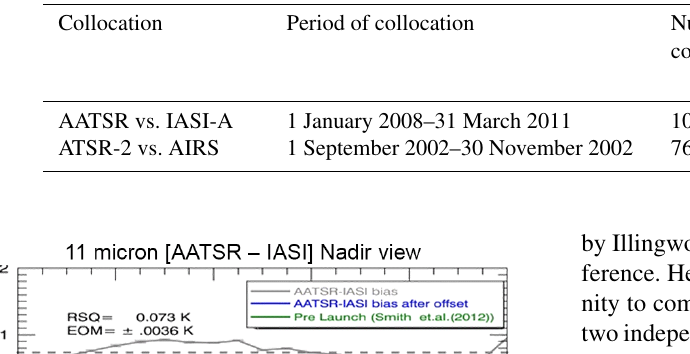
Table 2. Number of collocations produced by the collocation algorithm for AATSR vs. IASI-A inter-comparison and ATSR-2 vs. AIRS inter-comparison (second last column). The last column displays the number of collocations obtained after applying threshold stated in Table 1 that are eventually used in this study.